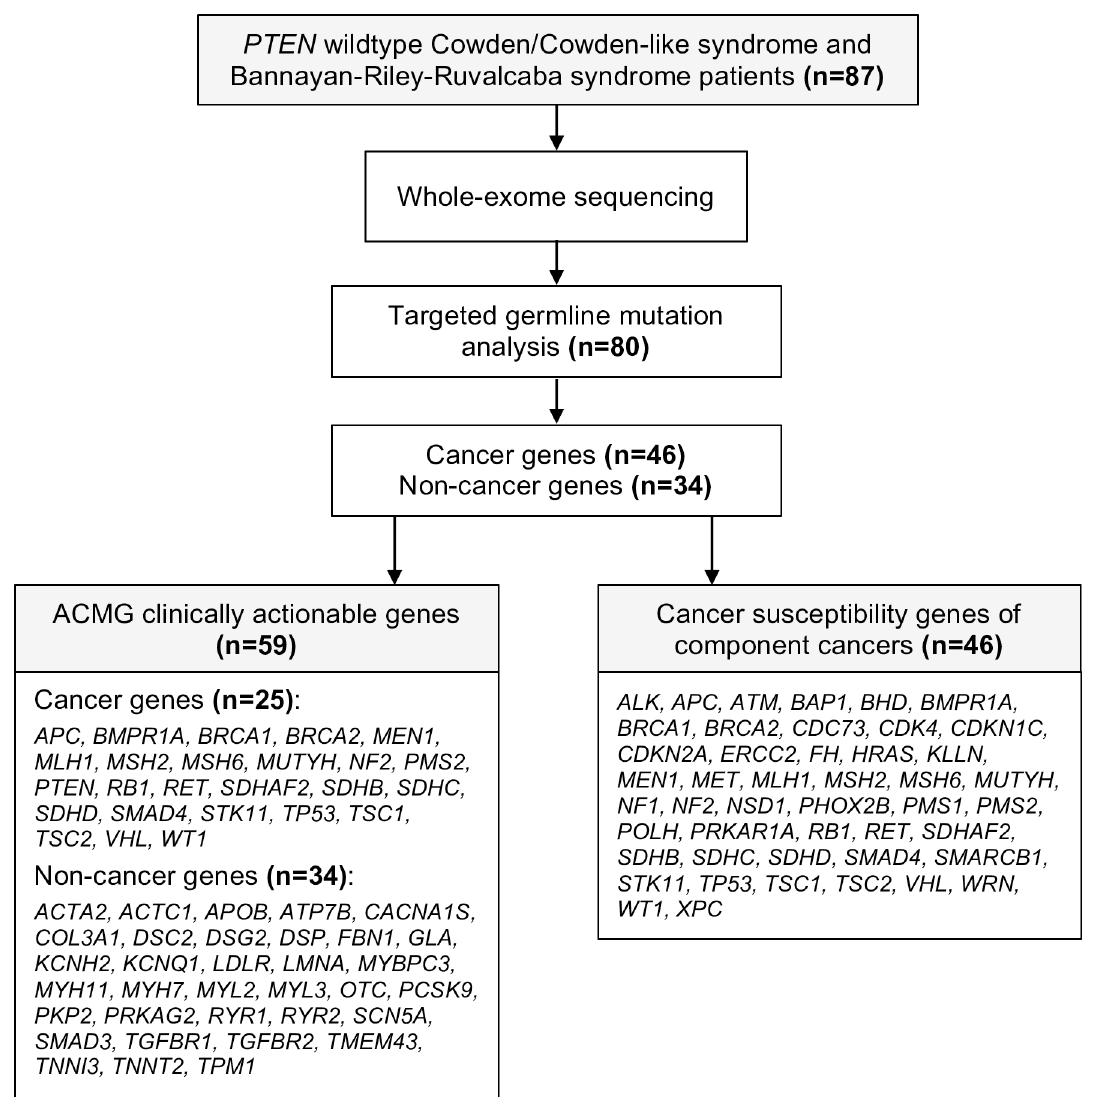
Fig 1. Study design and testing strategy. ACMG indicates American College of Medical Genetics and Genomics. Component cancers represent malignancies observed in PHTS patients.